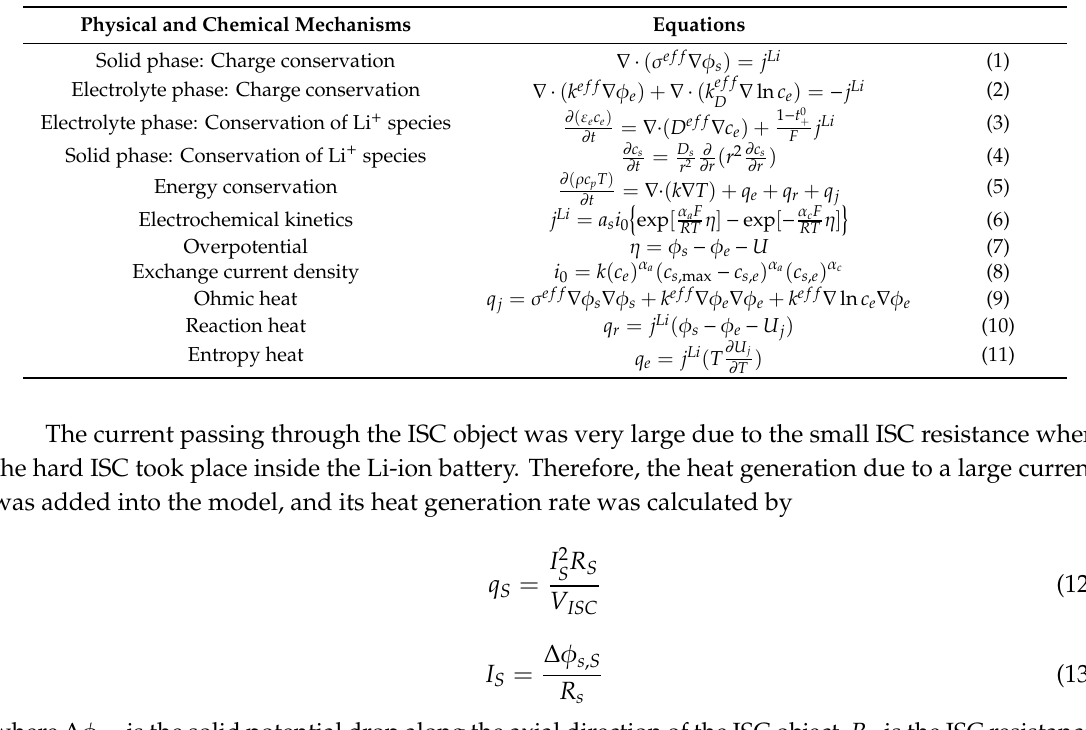
Table 2. Governing equations of the axisymmetric model.